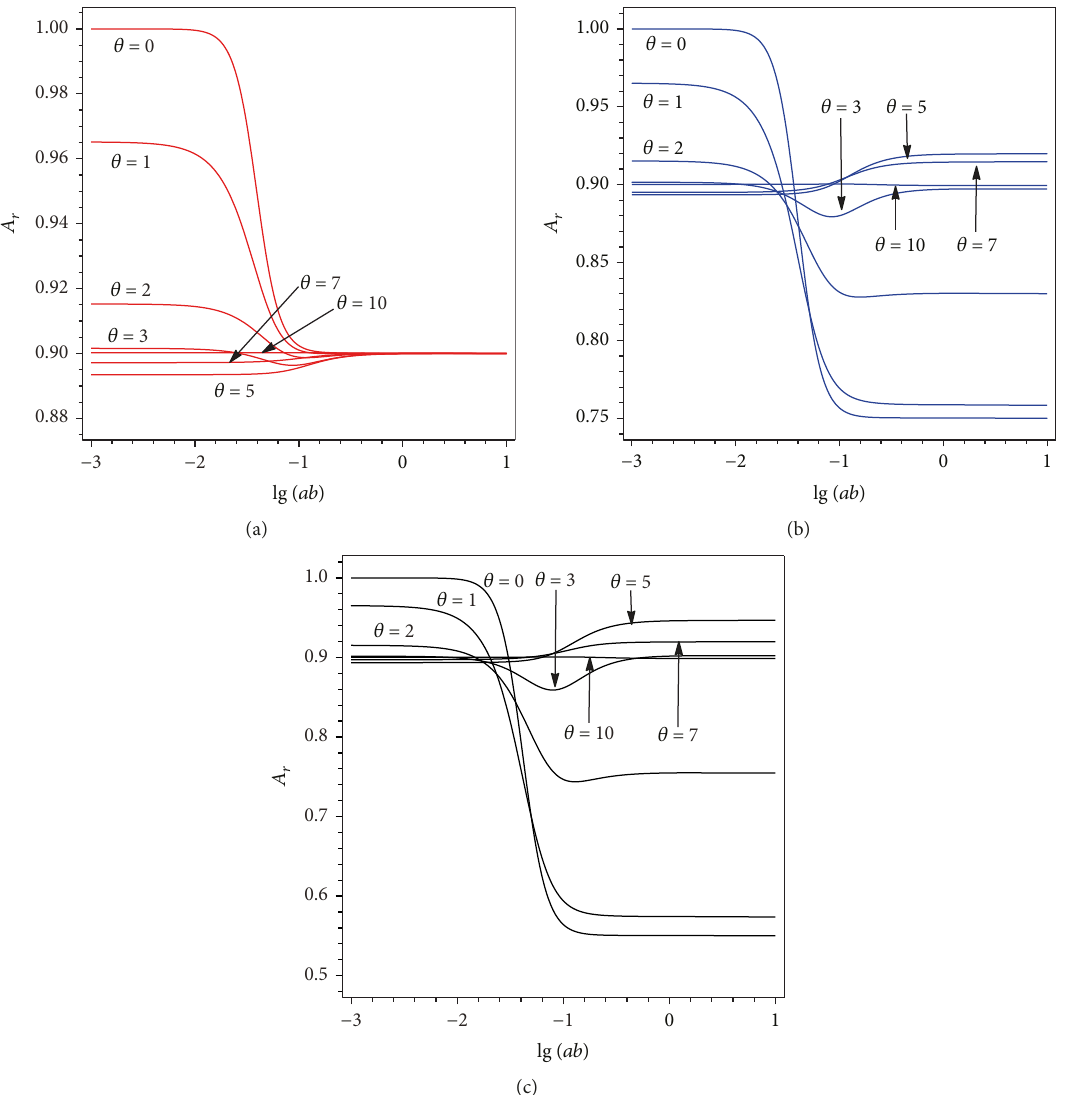
Figure 4: Changes of the amplitude ratio A when L is equal to (a) 0.8, (b) 0.5, and (c) 0.1. The loading coe ffi cient L e 1